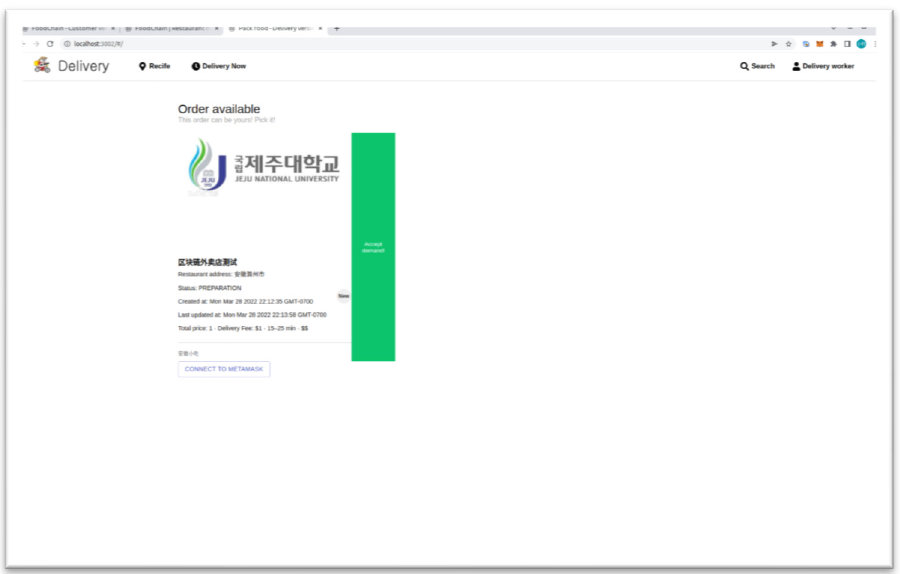
Figure 43. Restaurant client demo part in DAPP (Delivery order).